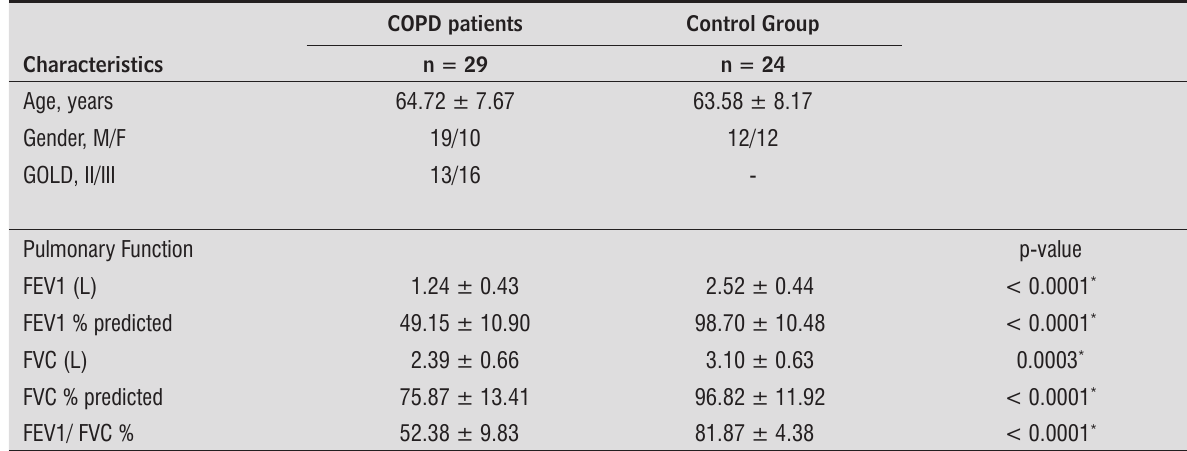
Table 1 - Characteristics of study participants and comparison of lung function mean values COPD patients